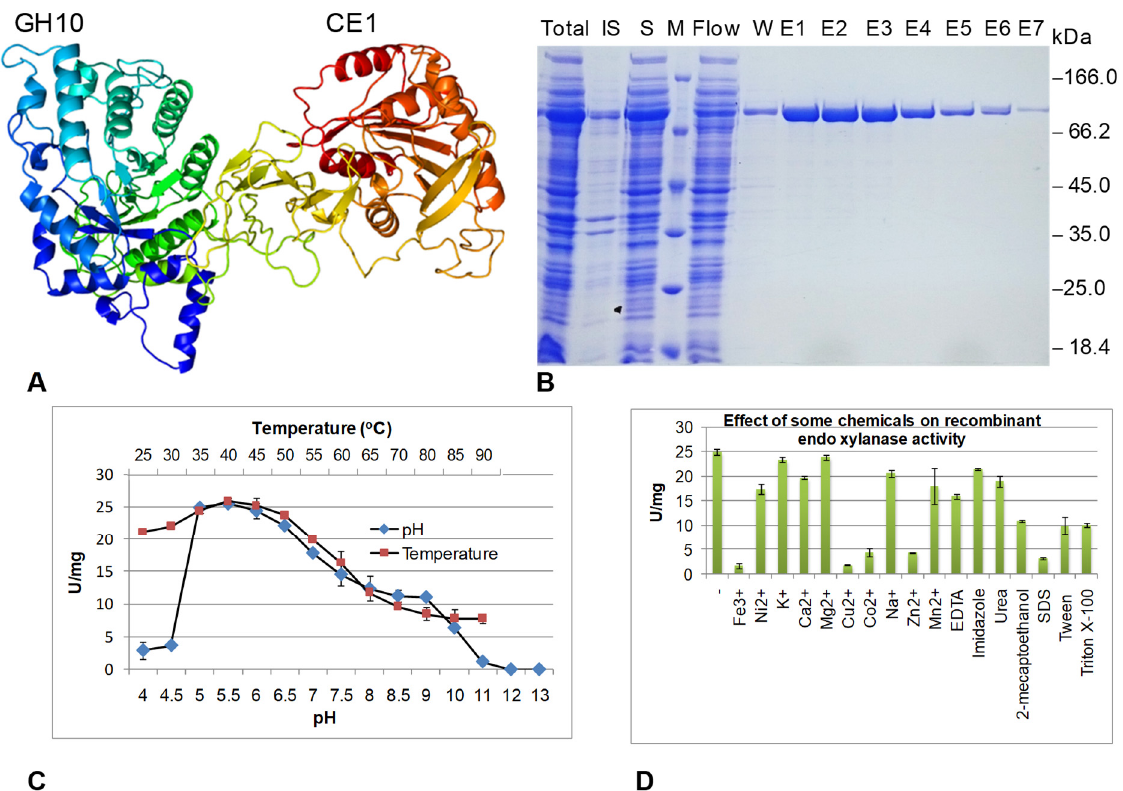
Figure 7. Expression, purification, and characterization of recombinant endoxylanase. ( A ) Three-dimensional structure of endoxylanase built by Phyre2; ( B ) SDS-PAGE analysis of the enzyme expression in E. coli Rosetta 1 strain and fractions during the enzyme purification process; ( C ) Effect of pH and temperature on recombinant endoxylanase activity towards to birchwood xylan; ( D ) Effect of some chemicals on the recombinant enzyme activity. Total: total proteins; IS: insoluble fraction; S: Soluble fraction; M: Standard protein marker (Fermentas); Flow: Unbound proteins have passed through the affinity column; W: Washed fraction; E: Eluted fraction.